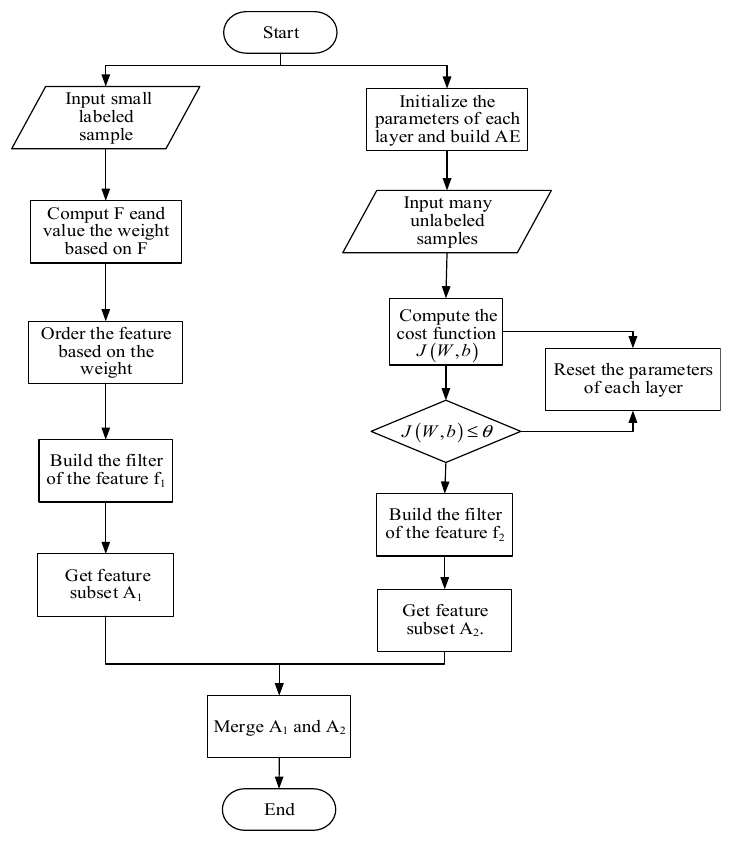
Figure 2. The architecture of DFA-F-DAE.